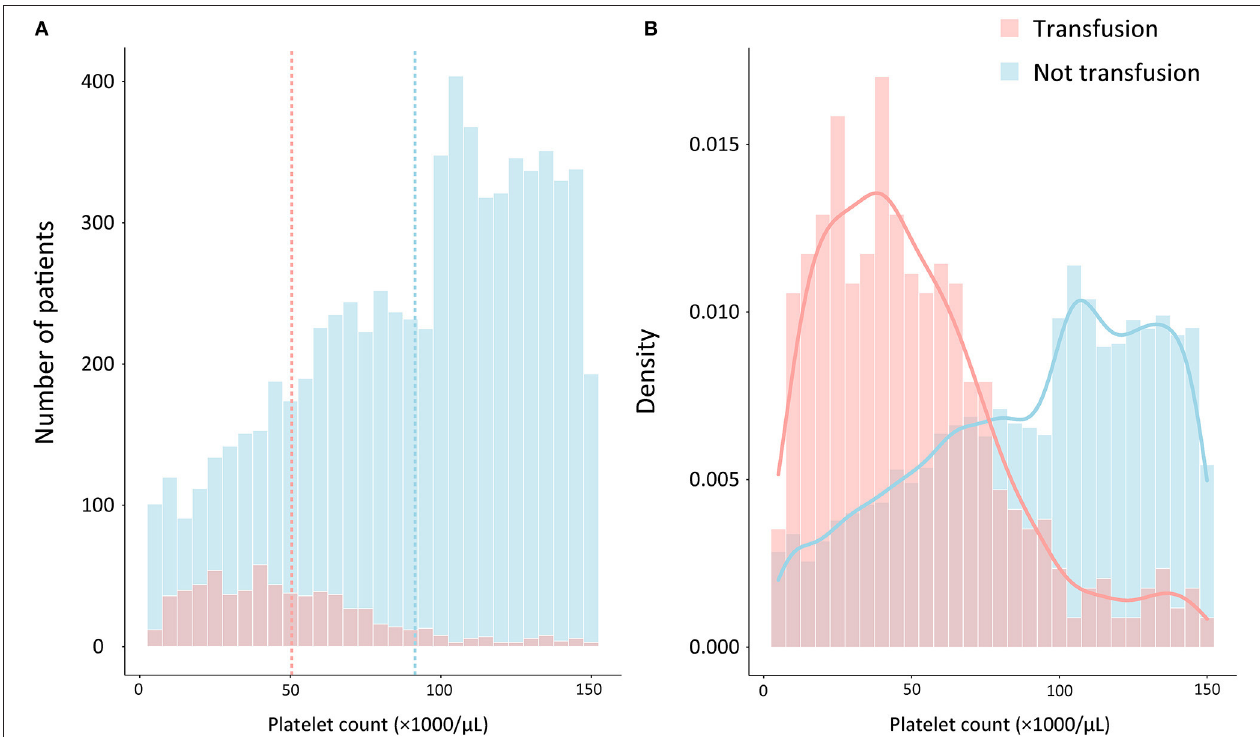
FIGURE 2 | Distribution of patients by platelet counts and the proportion of platelet transfusion on admission among septic patients with thrombocytopenia. (A) The frequency distribution of the number of platelet counts, with the vertical dashed lines representing the mean platelet count for transfusion group (red) and not transfusion group (blue), respectively. (B) Probability density distributions of platelet counts for transfusion group (red curves) and not transfusion group (blue